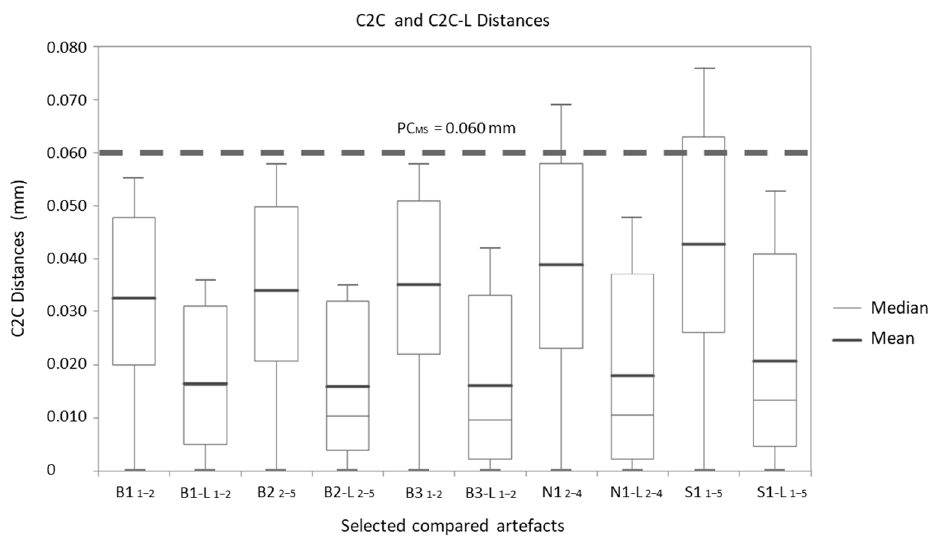
Figure 9. Box-Plots showing the Q 95 percentile (whiskers) of absolute distance errors (C2C distance and C2C-L local distance) among the 3D point cloud models in the 3D comparison after registration using the ICP method. Distance range was referenced to PC MS (Point Cloud minimum spacing).